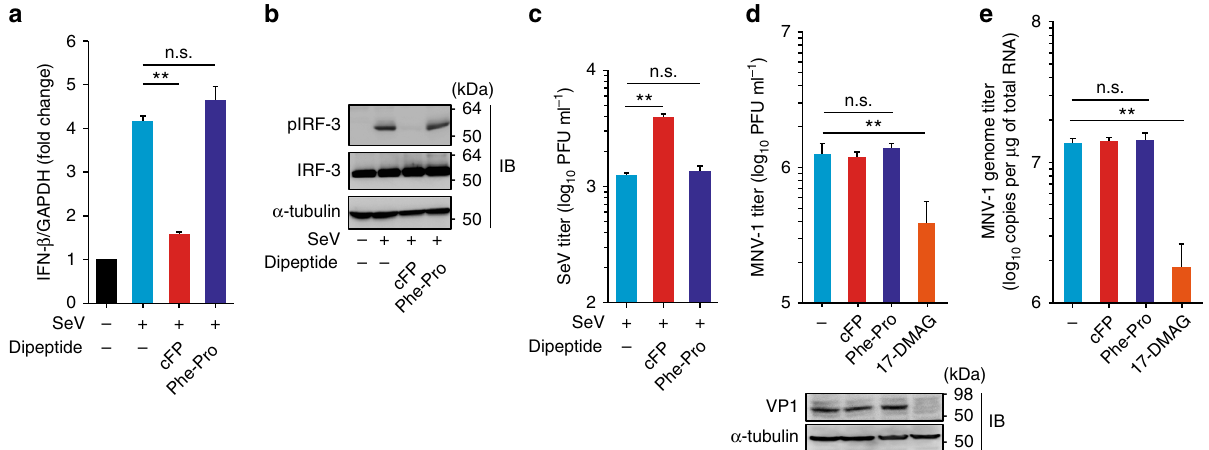
Fig. 4 Differential effect of cFP on SeV and norovirus replication. a – c HEK293T cells infected with SeV were treated with 2.5 mM cFP or Phe-Pro. After 24 h, cells were harvested to assess IFN- β mRNA levels ( a ), IRF-3 activation ( b ), and infectious virus titers in culture media ( c ). d , e Mouse macrophage cells (RAW264.7), which were infected with mouse norovirus (MNV-1) at an MOI of 0.005, were treated with 2.5 mM cFP or Phe-Pro. 17-DMAG (300 nM), an Hsp90 inhibitor known as an anti-norovirus reagent, served as a positive control. After 24 h, infectious virus titer in culture media and intracellular viral genome levels were determined by a plaque-forming assay ( d ) and RT-qPCR ( e ), respectively. Immunoblot for the MNV-1 VP1 is shown below the bar graph in d . ** P < 0.01; n.s., not signi fi cant; by unpaired two-tailed Student ’ s t -test